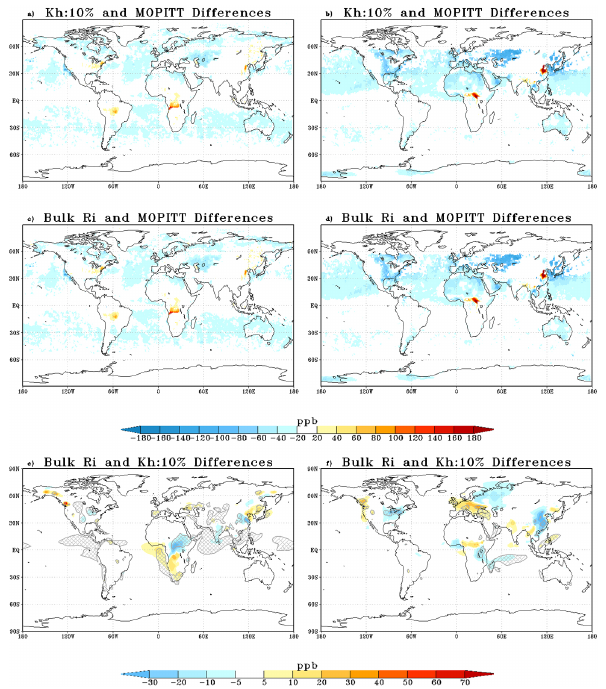
Figure 18. Seasonal mean column CO 2 differences. Method 2 mi- nus ACOS for JJA (a) and DJF (b) , Method 3 minus ACOS for JJA (c) and DJF (d) , and Method 3 minus Method 2 for JJA (e) and DJF (f) . Model comparisons to ACOS have been sampled using the ACOS averaging kernel. Hatch marks on the bottom plots represent significance at the 90% level using the Student’s t test. Crosshatch marks represent significance at the 95%